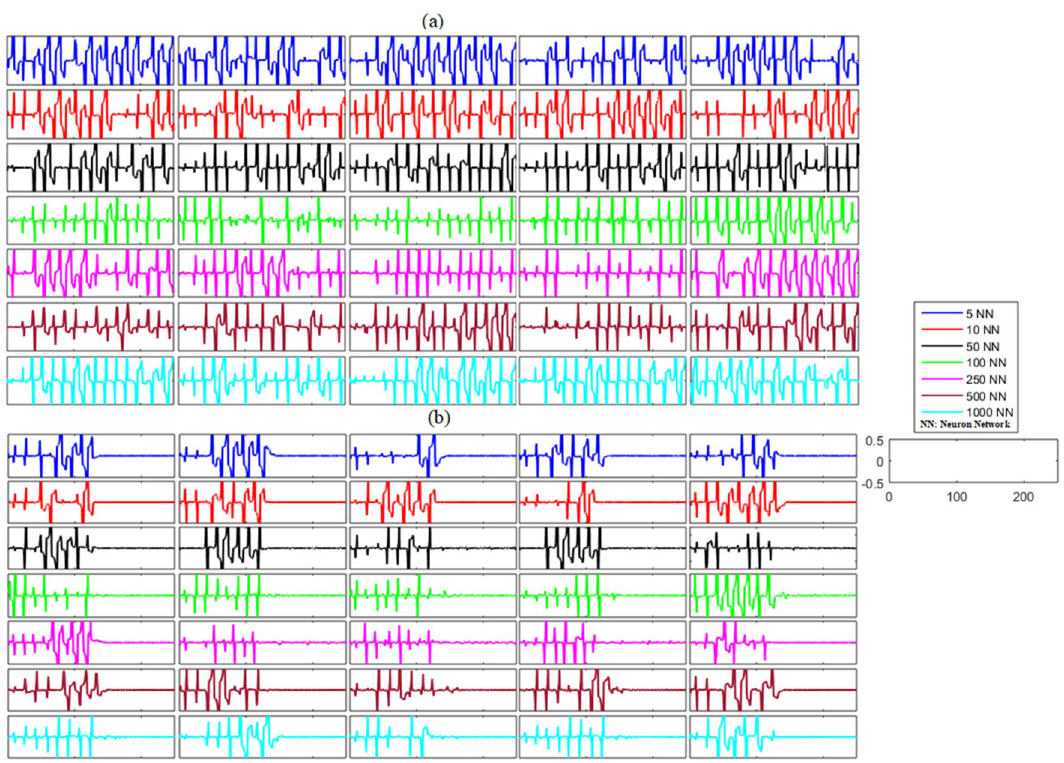
Figure 8. ( a ) Without control synchronization dynamics of the membrane potential states (x-states) of different time-delayed bidirectional FHN networks with noise. ( b ) Controlled synchronized error dynamics of the membrane potential states (x-state) of different time-delayed bidirectional FHN networks with